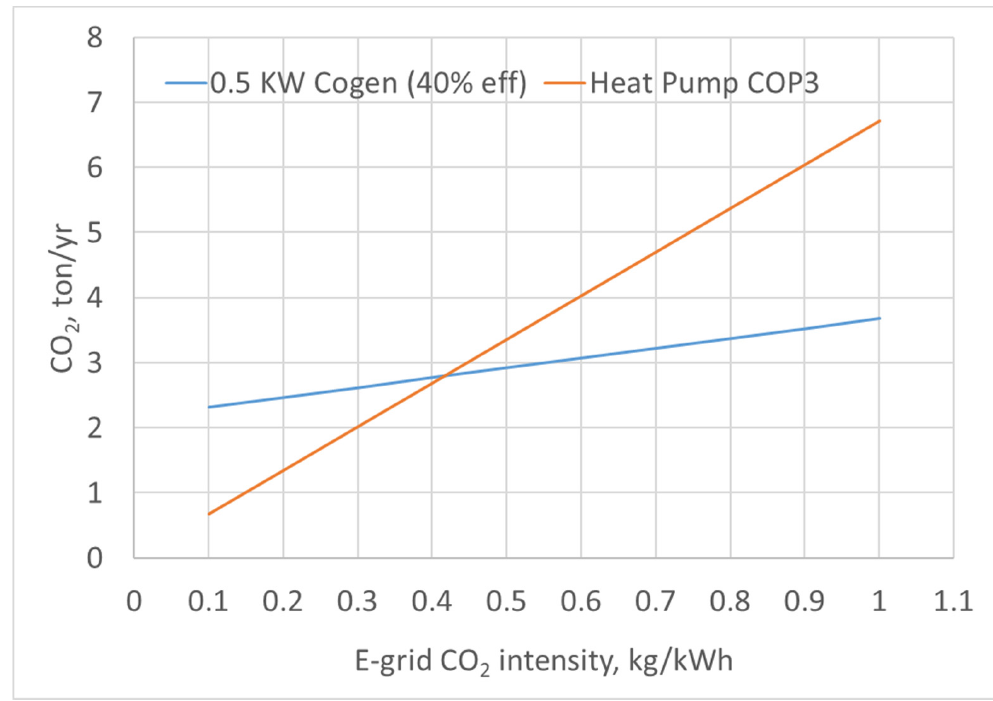
Figure 11. Annual carbon dioxide emissions of a residential building served by a 0.5 kW cogeneration system (40% electrical efficiency) or E-grid-supported heat pump system (COP-3).